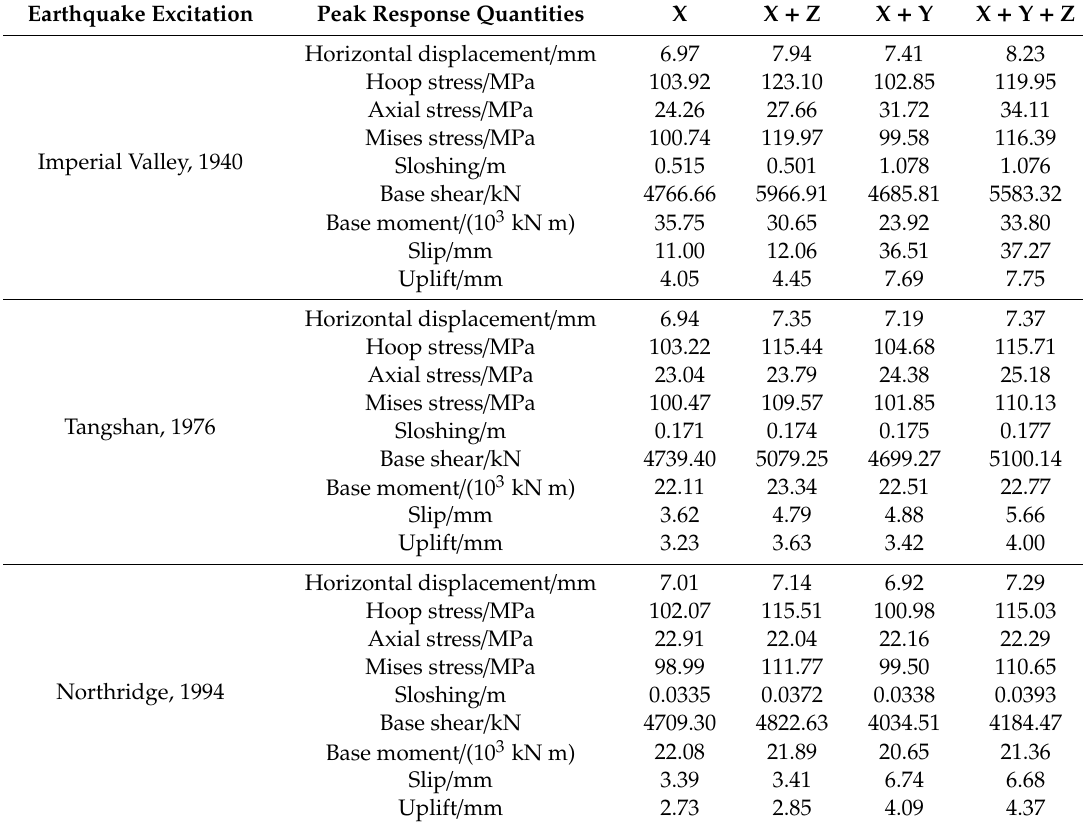
Table 3. Comparison of the peak response quantities under the four cases.